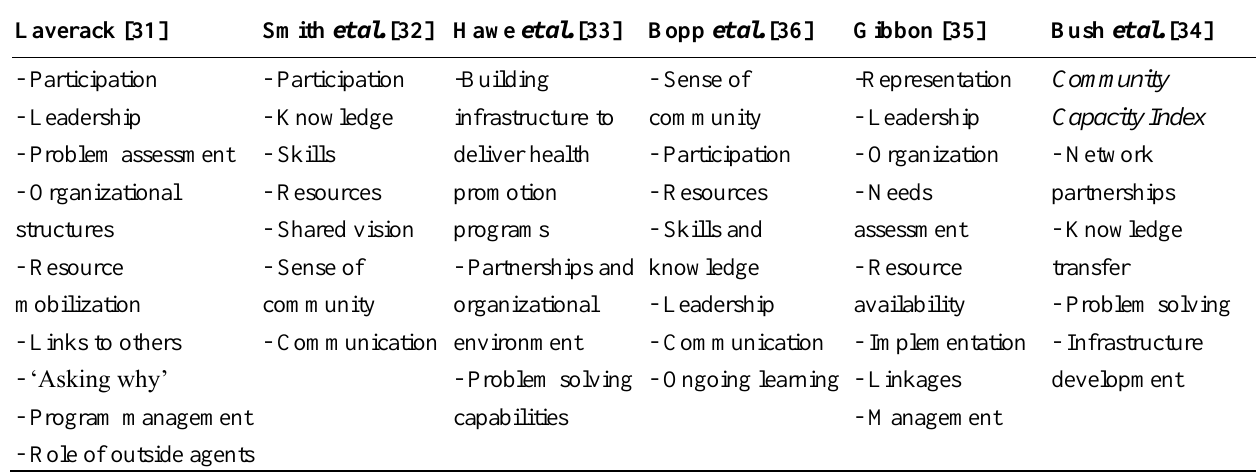
Table 1. ODCE by selected authors (adapted from